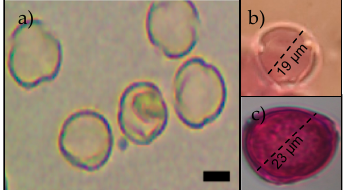
Figure 3. Details of a Calceolaria pollen grain with and without stain. ( a ) General view of pollen grains without stain, ( b ) pollen of C. cavanillesii and, and ( c ) pollen of C. filicaulis . The black bar represents a scale of 10 µm.